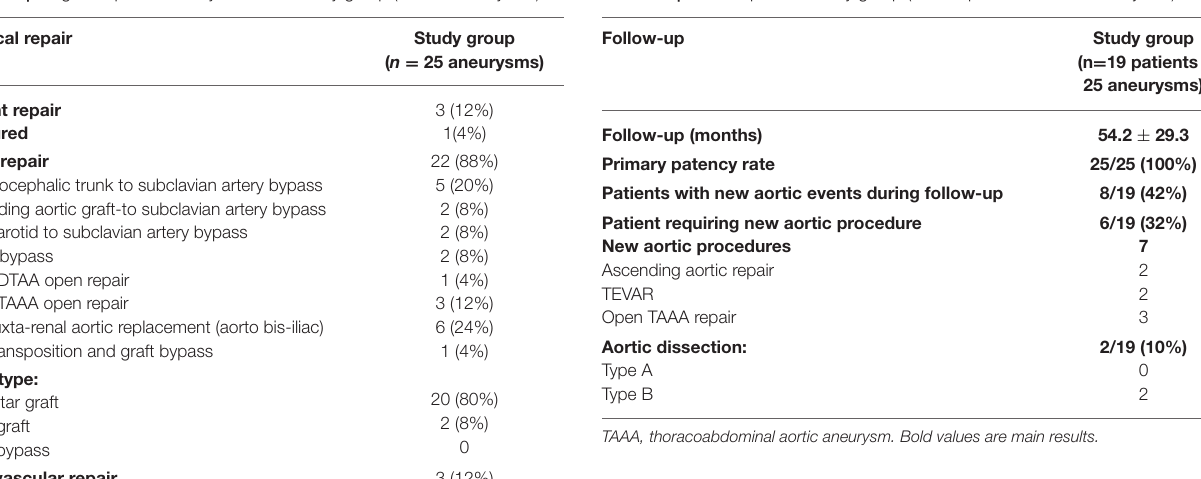
TABLE 3 | Follow-up of the study group ( n = 19 patients and 25